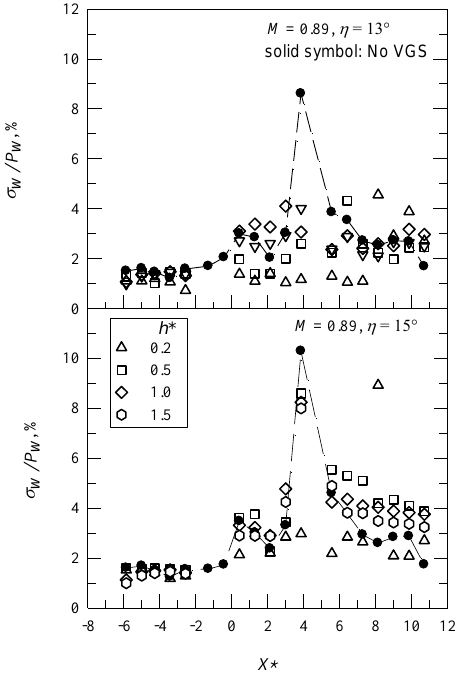
Figure 8. Distributions of pressure fluctuations distribution for M = 0.89. The variation in ( σ p / P w ) max with β is shown in Figure 9. For the baseline case, the am- plitude of ( σ p / P w ) max increases with β . The presence of VGs results in a decrease in the am- plitude of ( σ p / P w ) max , which is more significant as h* increases. The data also shows the effect of M . The value of ( σ p / P w ) max differs more significantly from the value for the baseline